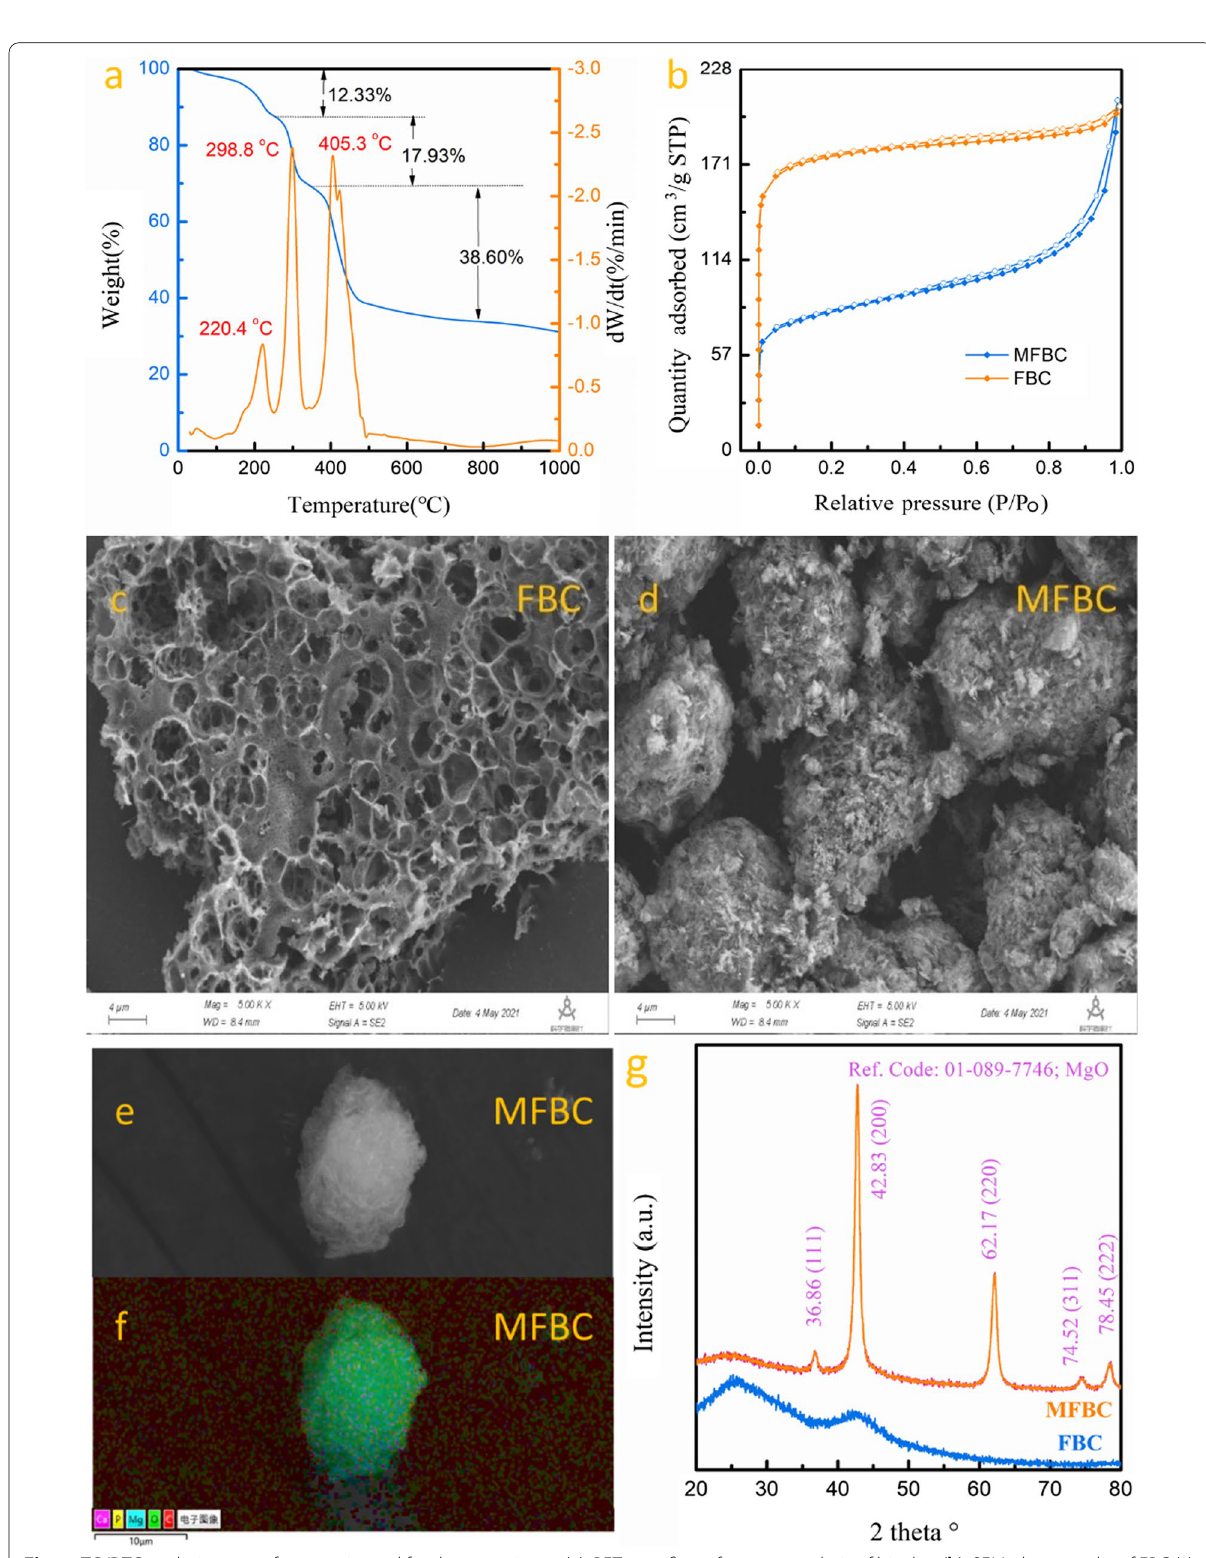
Fig. 1 TG/DTG analysis curve of magnesite and food waste mixture ( a ), BET-specific surface area analysis of biochar ( b ), SEM photographs of FBC ( c ) and MFBC ( d ), selected SEM photographs of MFBC ( e ) and related elemental distribution in EDS-mapping ( f ), and XRD patterns of FBC and MFBC ( g